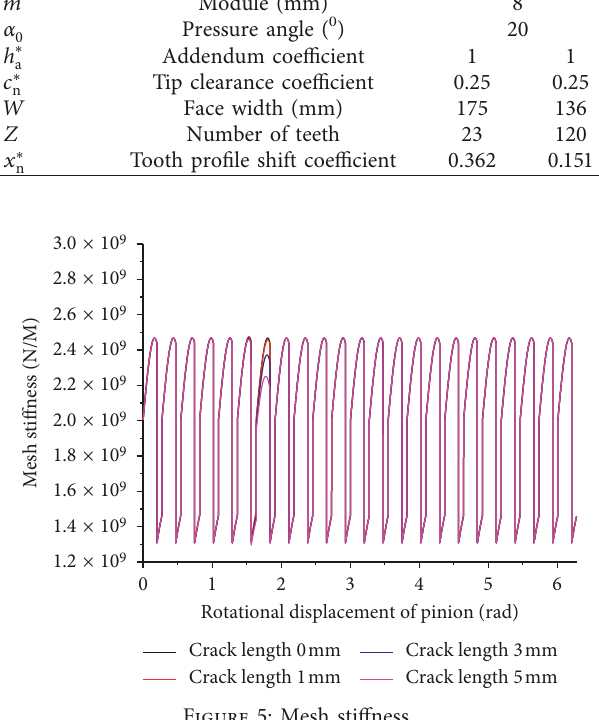
Figure 5: Mesh stiffness.